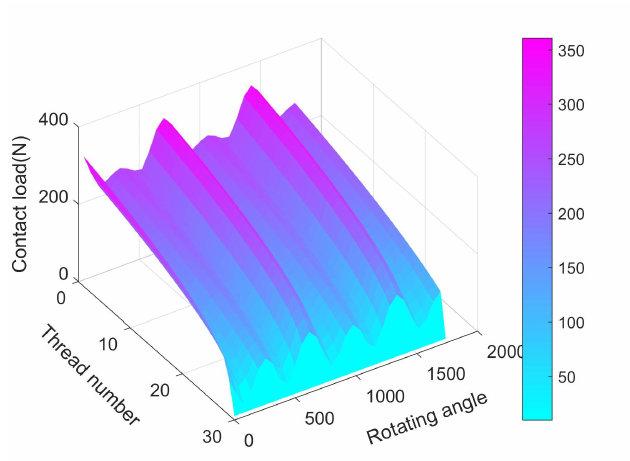
Figure 12. Contact load distribution cycling process with radial load of case 1.